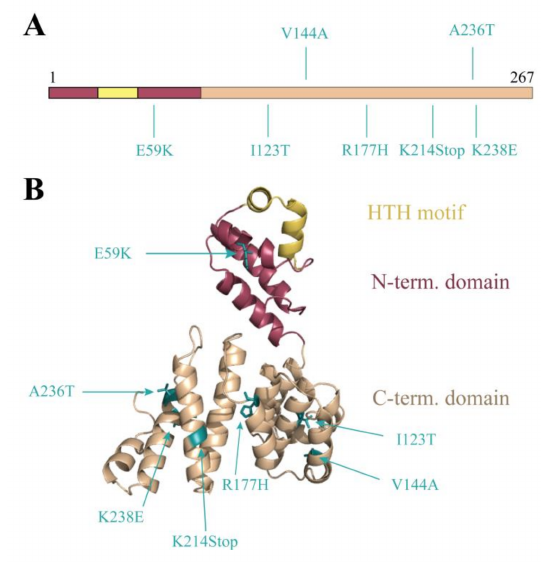
Figure 4. Probing DNA binding by random mutagenesis: Random mutagenesis PCR was carried out on the Stl coding sequence generating various single mutations. The PCR product was cloned into pKW08 vector and electroporated into the Stl switch system. The depicted mutants showed blue phenotype in the designed Stl switch system, suggesting defective DNA-binding ability. ( A ) The location of the hits in the Stl full-length protein; ( B ) Mutants mapped on the Phyre2 structural model of Stl